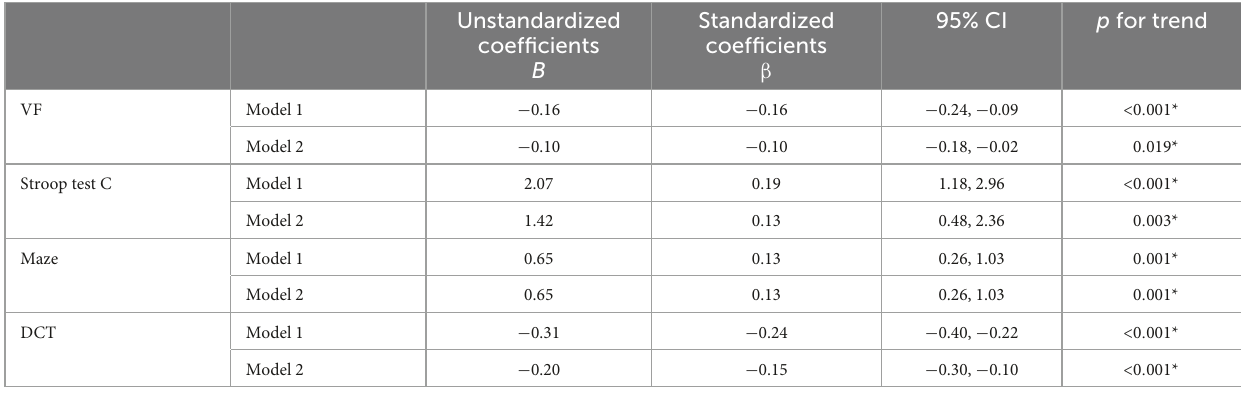
TABLE 3 Linear regression analysis of the relationship between CMB burden grades and cognitive test